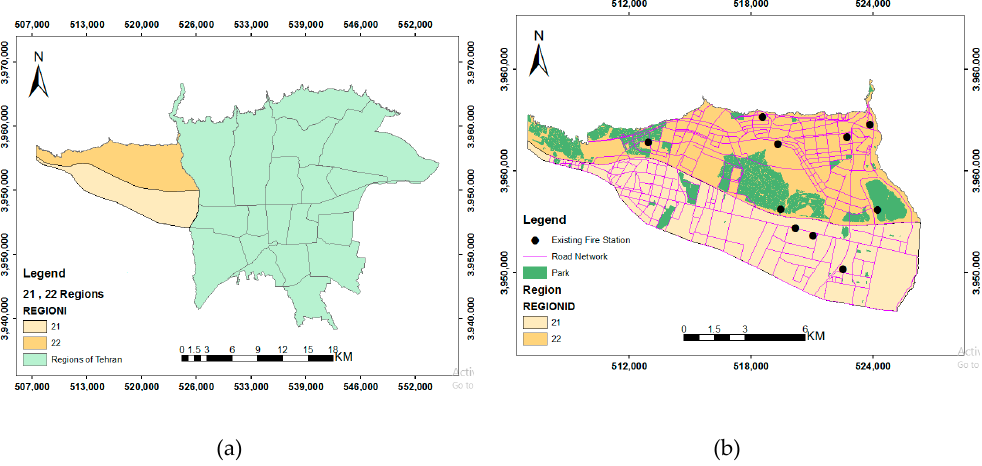
Figure 2. ( a , b ) Location of existing and potential fire stations and the main road network in Tehran’s 21 st and 22 nd districts (in UTM zone 39N map projection system).